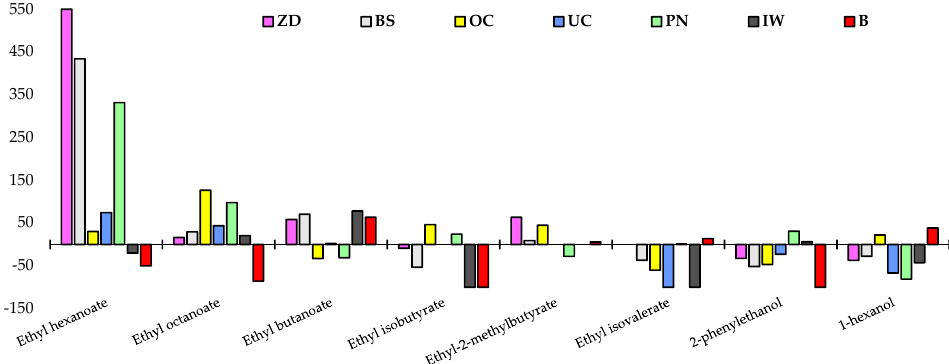
Figure 1. The increases and decreases of the mean concentrations (%) of each volatile aroma compound (VOC) between wines used for the dosage solutions. NV sparkling wine without sugar addition = zero dosage (ZD), NV sparkling wine + sugar (BS), unoaked still Chardonnay wine + sugar (UC), Pinot noir 2009 sparkling wine + sugar (PN), Brandy + sugar (B), Icewine (IW) + sugar and oaked still Chardonnay wine + sugar (OC).